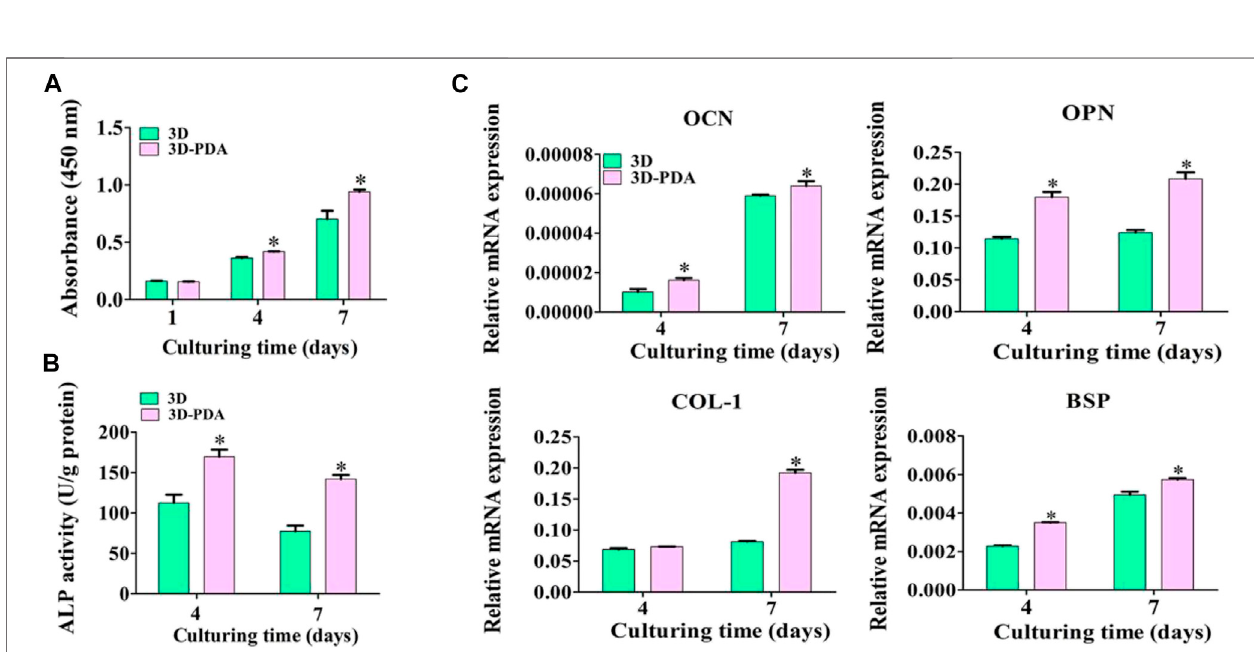
FIGURE 3 | Propagation of BMSCs on the 3D and 3D-PDA samples by CCK-8 test after seeding for 1, 4, and 7 days (A) . ALP activity (B) and RT-PCR analysis of the osteogenic gene expression levels (C) after culturing BMSCs for 4 and 7 days on the 3D and 3D-PDA group surfaces. * p < 0.05.